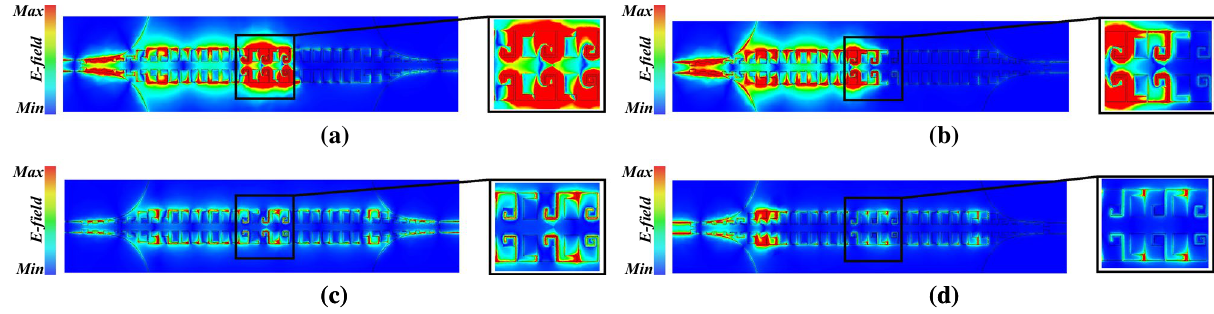
Figure 8. Electric field distribution of the filter at ( a ) 23.6 GHz, ( b ) 24.5 GHz, ( c ) 28 GHz, ( d ) 30 GHz. CST microwave studio 2020 (https:// www. 3ds. com/ produ cts- servi ces/ simul ia/ produ cts/ cst- studio- suite/) was used to generate this